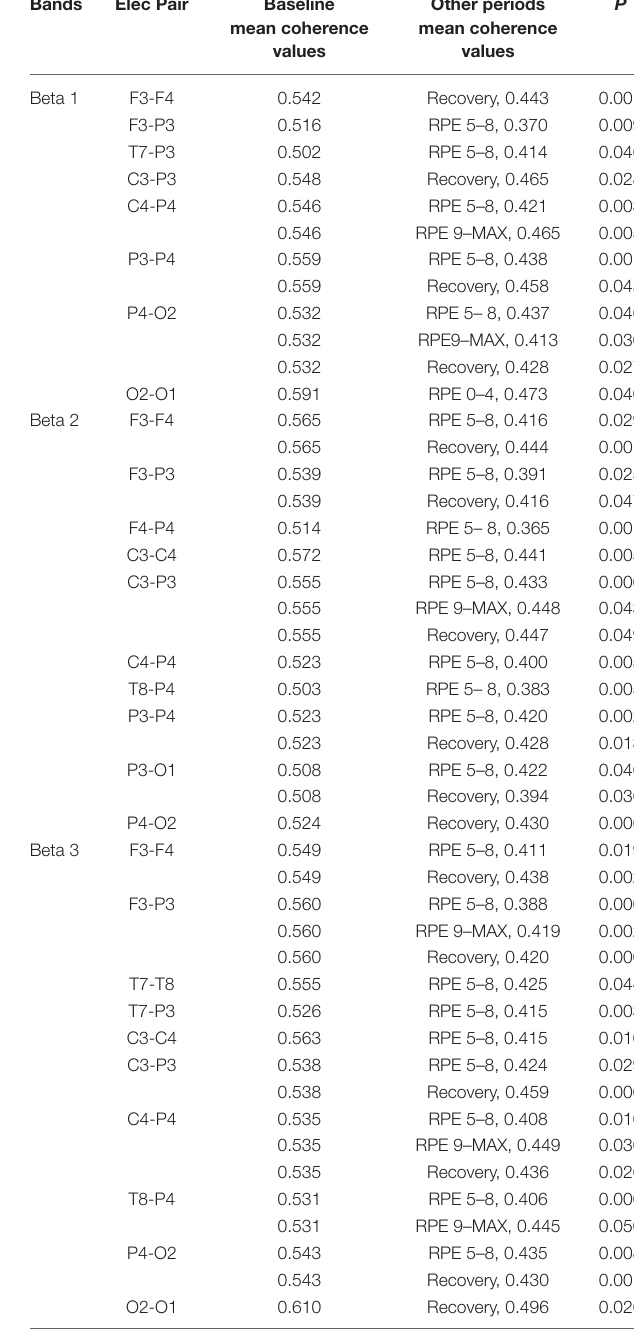
TABLE 3 | Post-hoc pairwise comparisons on effort level in beta